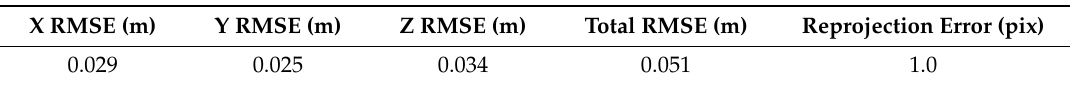
Table 5. Check Points RMSE.